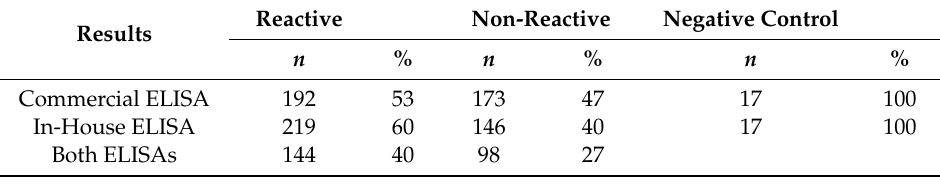
Table 1. Comparative analysis and concordance between commercial and in-house ELISAs.